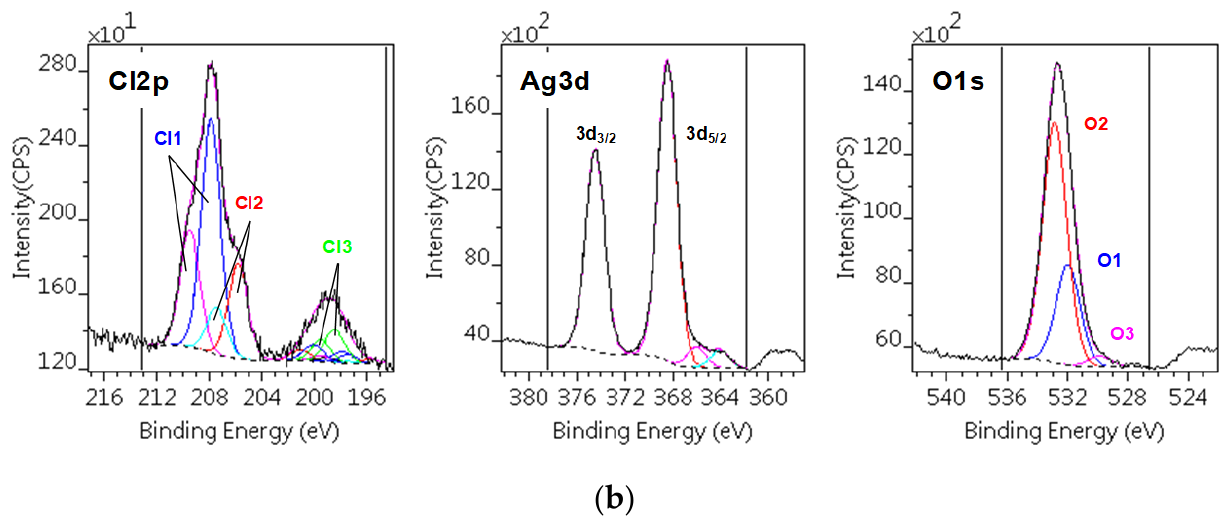
Figure 13. The XPS spectrum of the ( a ) I-240 and ( b ) the solid isolated from the aq. extract of I-240 . Summarizing the IR, XRD, and XPS results, the reduction process is not a single- step process, but probably different parallel and consecutive reactions take place with intermediates like AgClO, AgClO 2 , and AgClO 3 , or their NH 3 complexes. Taking into consideration the gaseous and solid reaction products, the relative amounts of these, the IR and XPS results of the intermediates, and the decomposition temperatures of AgClO, AgClO 2 , AgClO 3 , AgClO 4 , and their known ammonia complexes, we suggest the following general decomposition scheme (Figure 14). The stable intermediate complex formed at the beginning of decomposition (180–240 ◦ C) may only be a material containing chlorate.